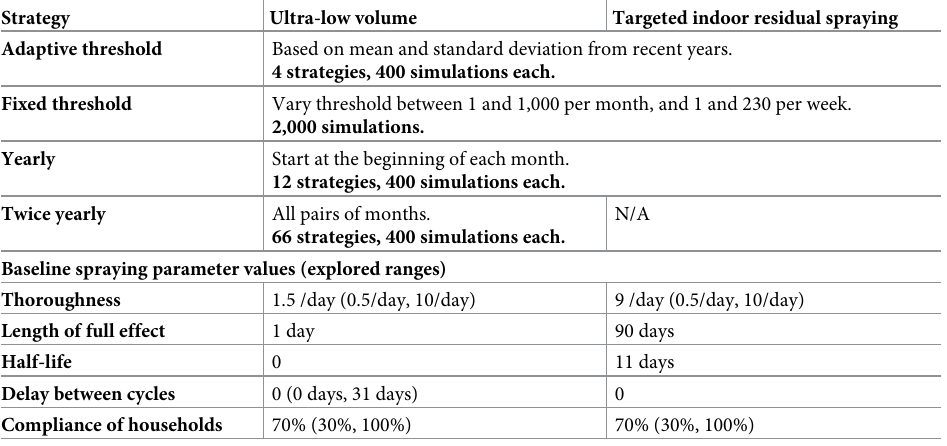
Table 1. Summary of simulation experiments. Thoroughness refers to the initial increase in mosquito mortality in sprayed houses. In the case of TIRS this begins to decay with the given half-life after the length of full effect.